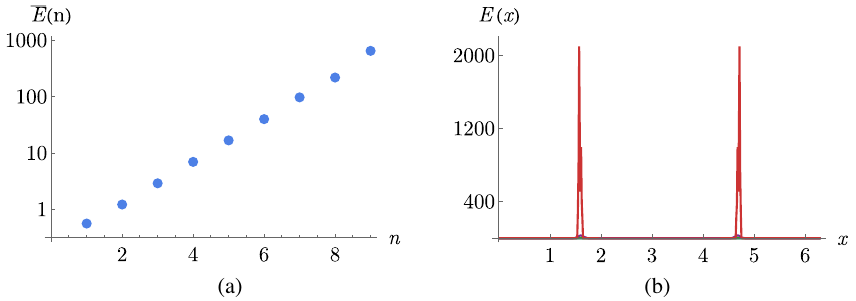
FIG. 13. Dynamics in the heating phase regime with small randomness. We choose L ¼ 2 π , T 0 ¼ 0 . 9 L , T 1 ¼ 0 . 15 L , and α ¼ 0 . 01 . Each data point is averaged over 100 times. (a) Averaged total energy still grows with time exponentially. (b) The energy density distribution is the same as that without any randomness, except that the peaks are smeared out a